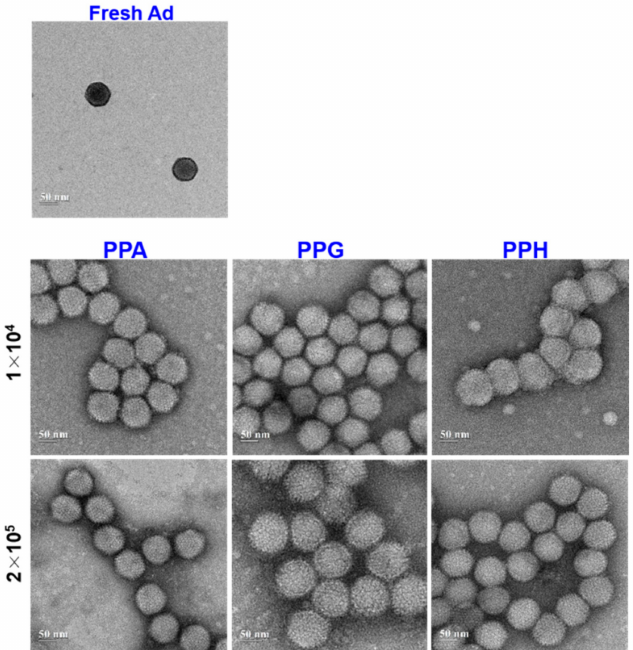
Figure 7. TEM images of fresh Ad and PPA-Ad, PPH-Ad, and PPG-Ad conjugates prepared at two different molar ratios (1 × 10 4 and 2 × 10 5 ) at pH 7.4.